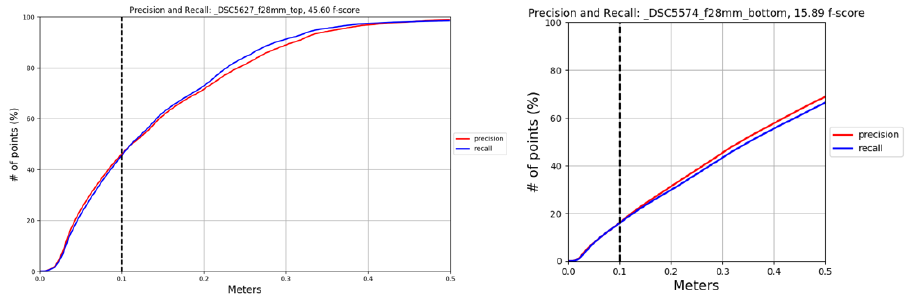
Figure 8. Experiment 2. Precision and recall curves for the two test images in Figure